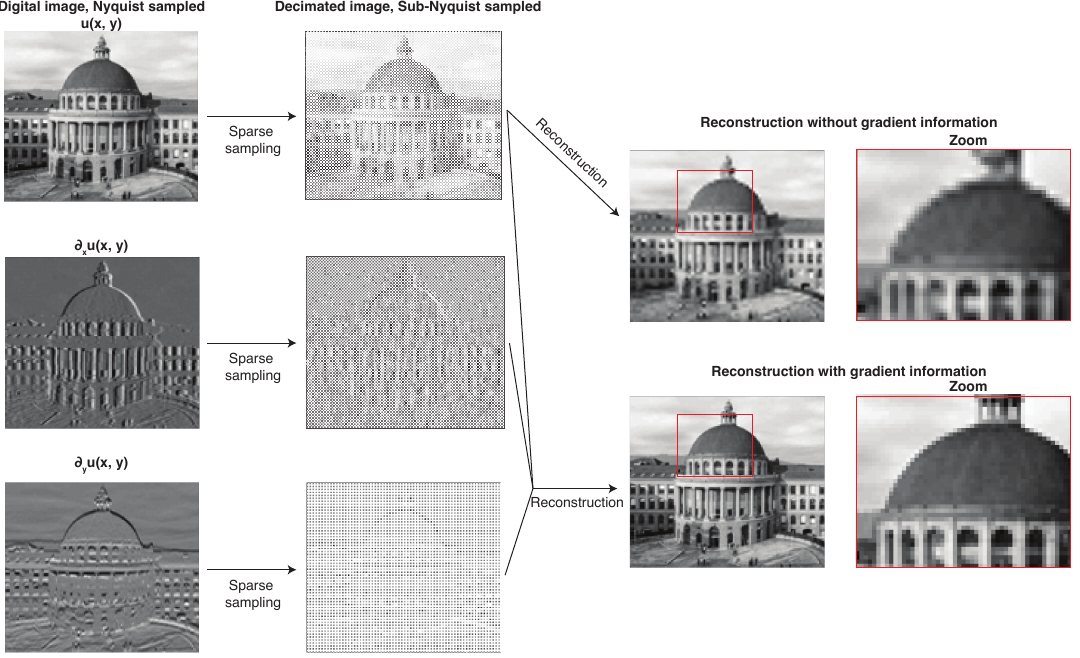
Figure 9. Image reconstruction of a picture of the ETH main building illustrating the power of using gradient information in reconstruction problems. The same idea can be applied to reconstruct seismic wavefields, if measurements of the wavefield’s gradients (e.g., due to a rotational sensor at the Earth’s surface) are